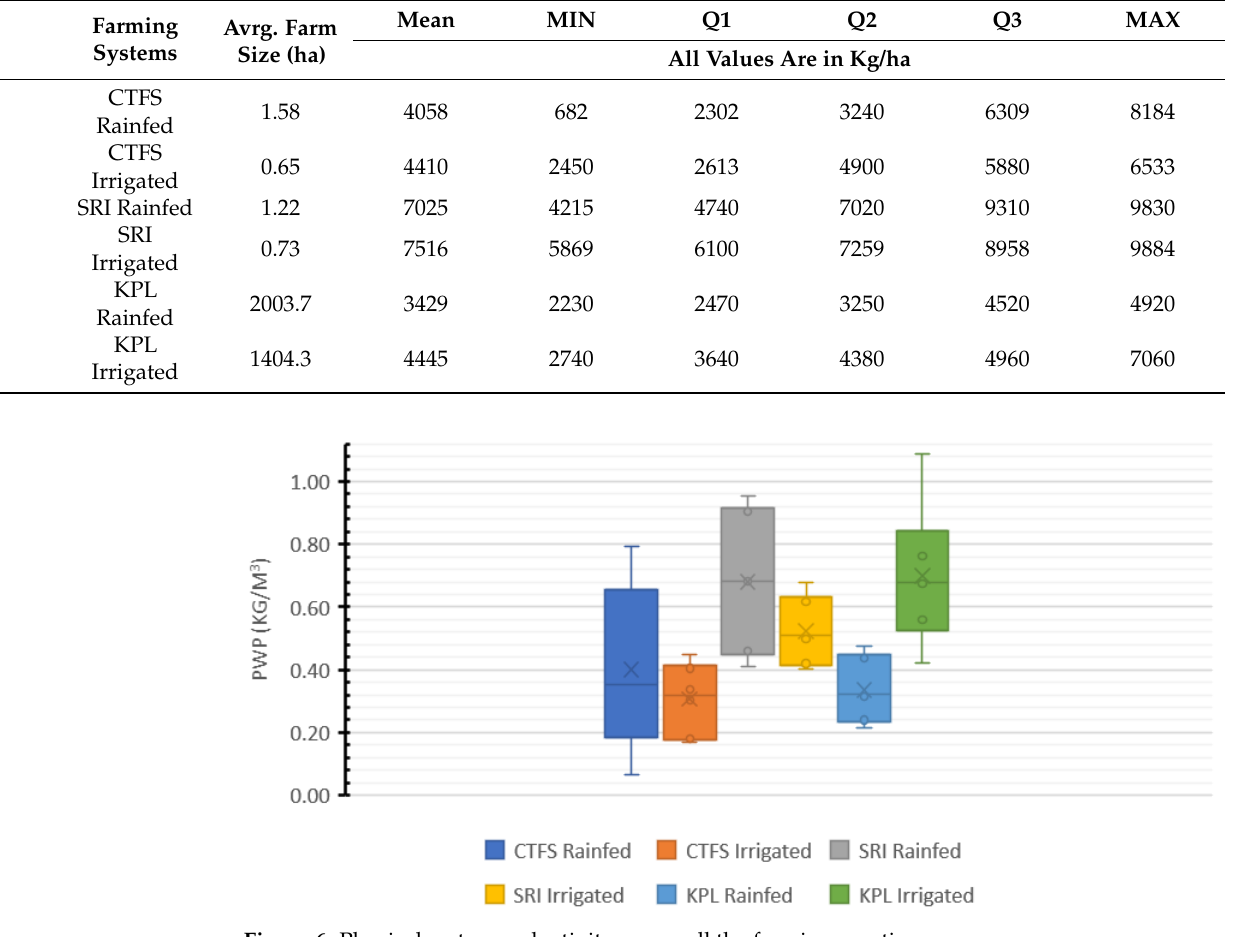
Figure 6. Physical water productivity across all the farming practices. Table 3. Descriptive statistics for physical water productivity (PWP) in all farming systems.